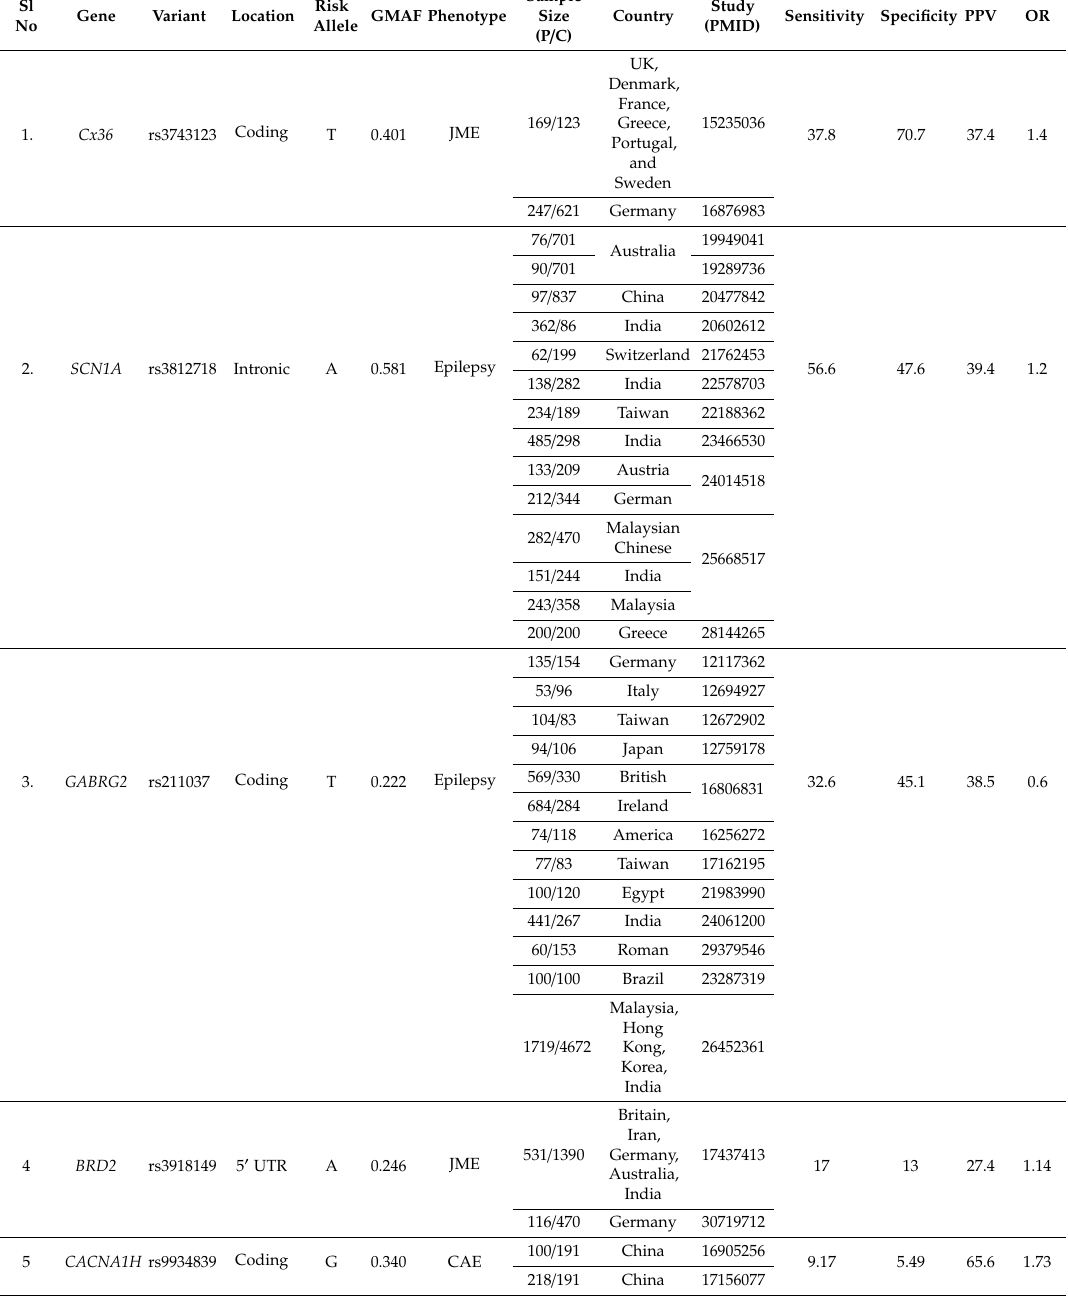
Table 4. Genetic marker for genetic testing in epilepsy with diagnostic e ffi